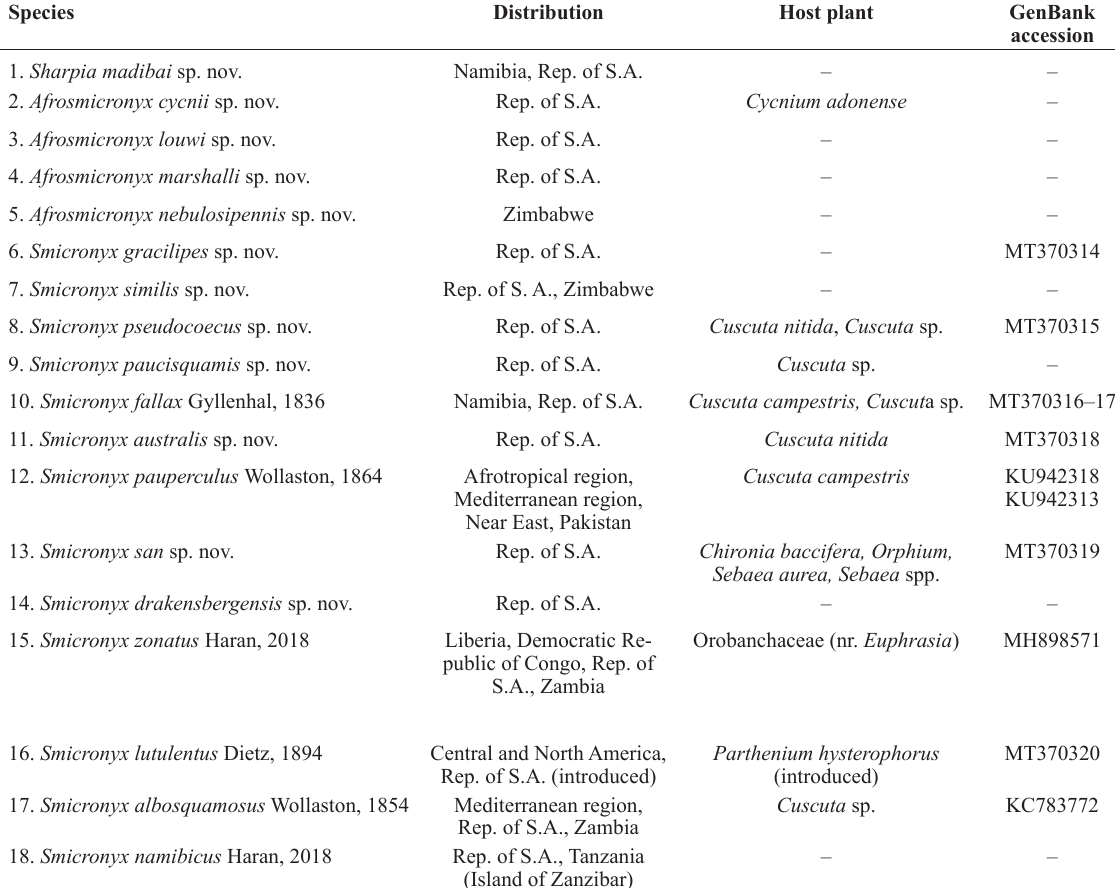
Table 1. Checklist, distribution and host plants of Smicronyx of southern